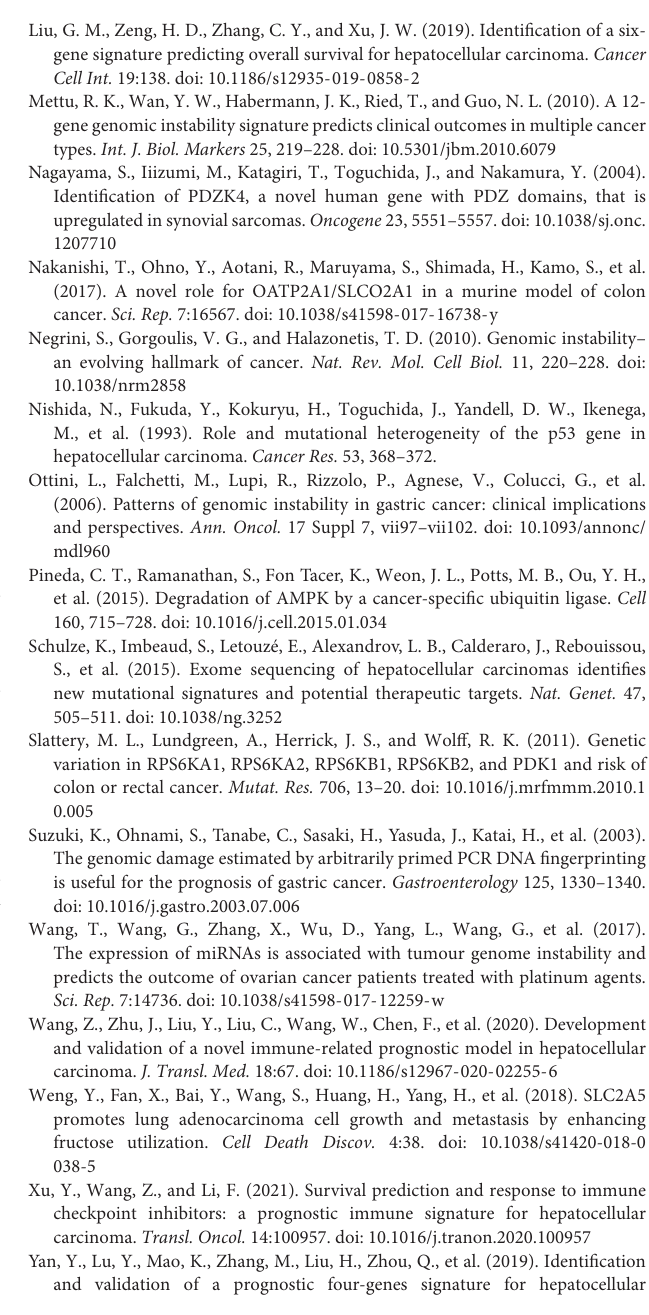
the TCGA and ICGC profiles. (G,H) Box plots of UBQLN4 expression level in the GU-like group and GS-like group of the TCGA and ICGC profile. Supplementary Figure 2 | Subgroup analysis of the training set (A,B) and ICGC set (C) . Supplementary Figure 3 | Subgroup analysis of the test set. Supplementary Figure 4 | Subgroup analysis the TCGA